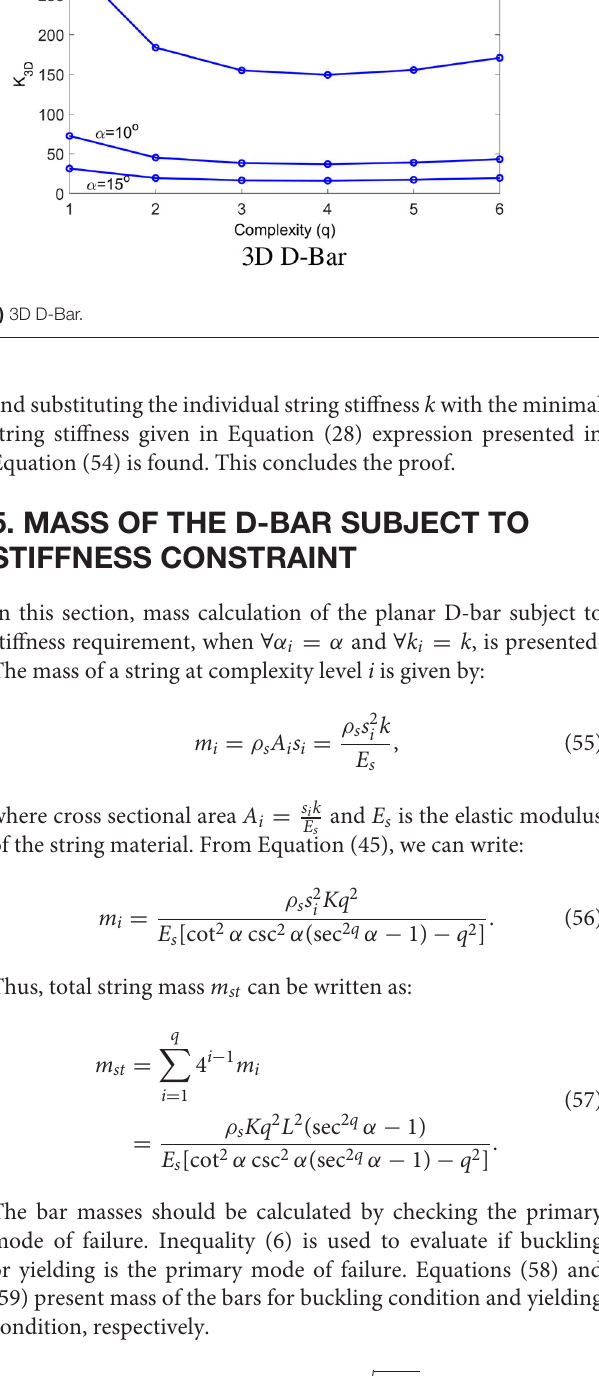
FIGURE 10 | Stiffness of the planar and 3D versions of the D-Bar. (A) Planar D-Bar. (B) 3D D-Bar.